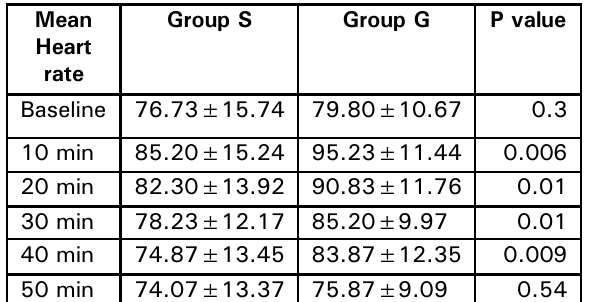
Table 6: Intraoperative mean MAP (mean arterial pressure) compared between two